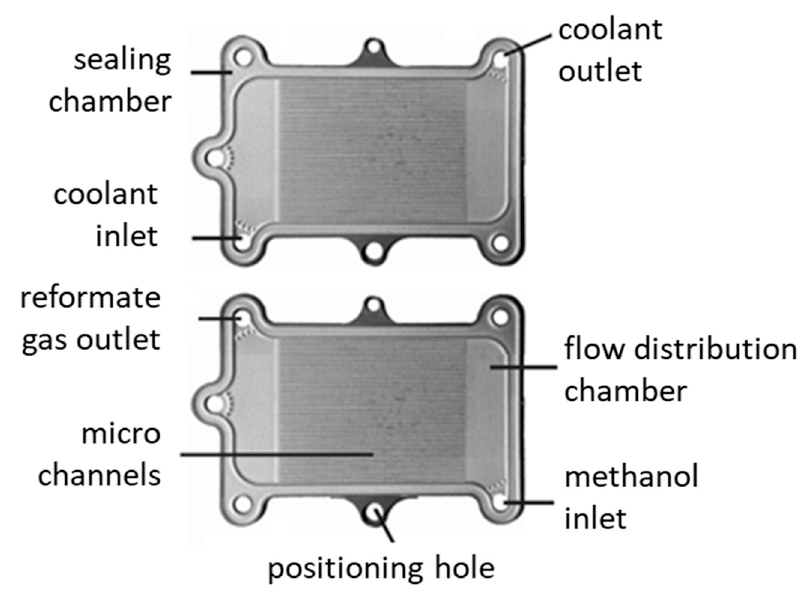
Figure 1. A top-view of the microstructured reactor/heat-exchanger plate geometry for counter-current operation; stacking of the two plate types creates a unit cell of the heat exchanger. For co-current configuration, the positions of the coolant inlet and outlet ports are inverted.